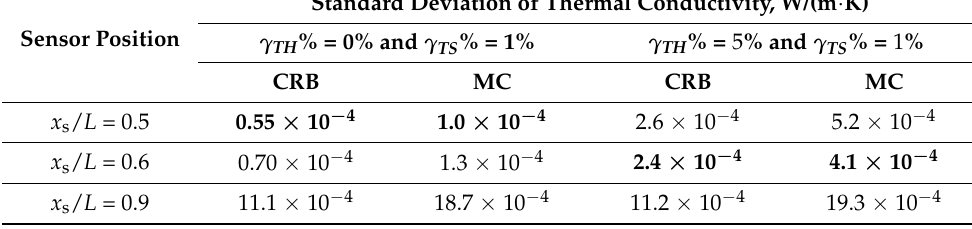
Table 1. Comparison of standard deviation of the retrieved conductive thermal conductivity esti- mated from the CRB method and MC simulations for various boundary temperature error values of γ TH % = 0% and 0.5, and various dimensionless sensor positions of x s / L = 0.5, 0.6 and 0.9, respectively. Standard Deviation of Thermal Conductivity, W/(m · K) Sensor Position γ TH % = 0% and γ TS % = 1% γ TH % = 5 % and γ TS % = 1 % CRB MC CRB MC x s / L = 0.5 0.55 × 10 −